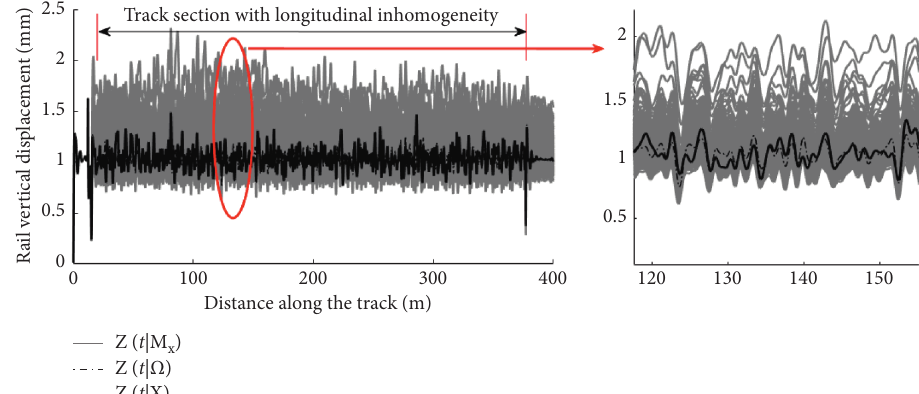
Figure 13: The responses of rail vertical displacement due to different excitations with CV of rail pad vertical stiffness � 0.20.